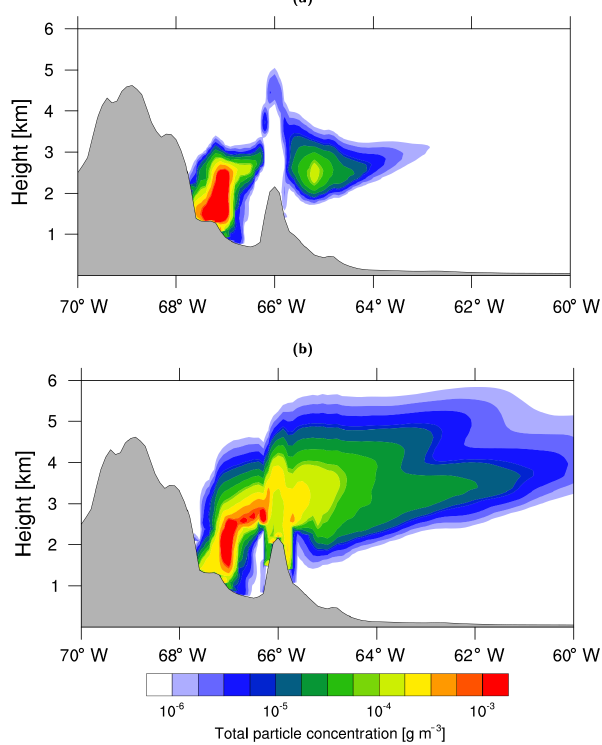
Figure 16. Modeled concentration on 13 June at 23:00UTC. West– east cross section along the red line in Fig. 15 (latitude: 28.2 ◦ S). Two numerical schemes are tested. (a) FALL3D default configu- ration. (b) Alternative configuration using a numerical scheme to more accurately compute the horizontal advection in abrupt terrains (see Eq. 10).